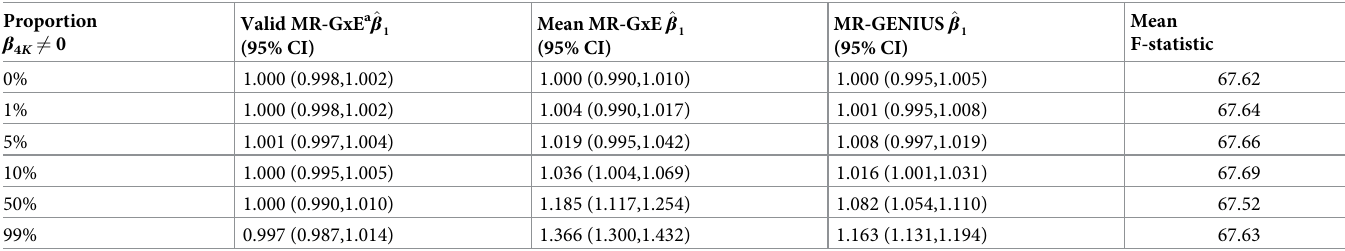
Table 3. Simulated results using differing proportions of non-zero gene-by-covariate interaction with respect to the outcome (simulation 5). Proportion β 4 K 6¼ 0